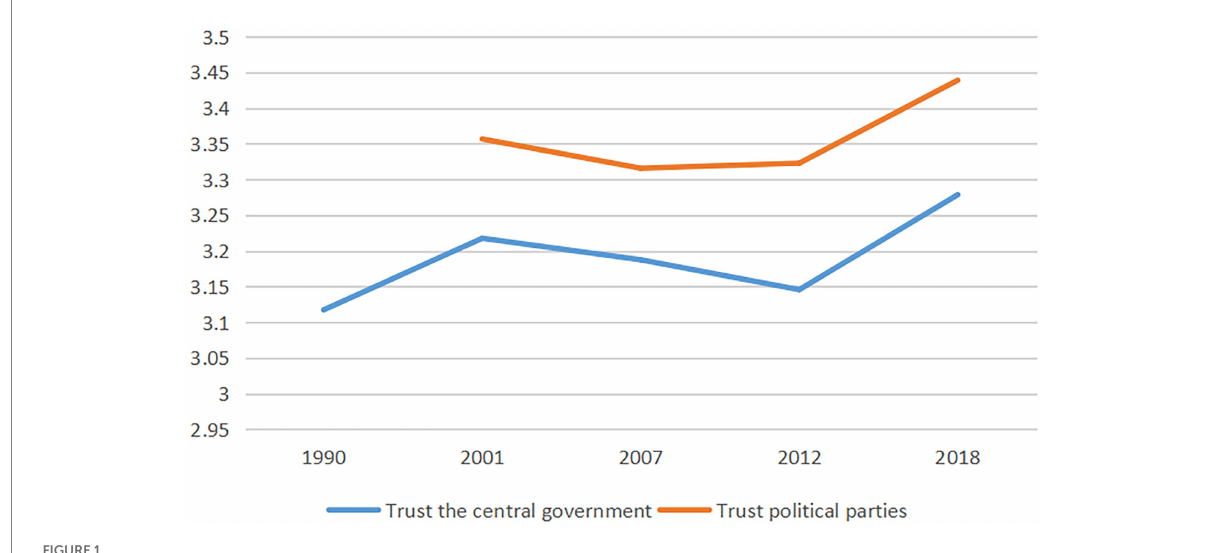
FIGURE 1 Trust in the Chinese government from 1990 to